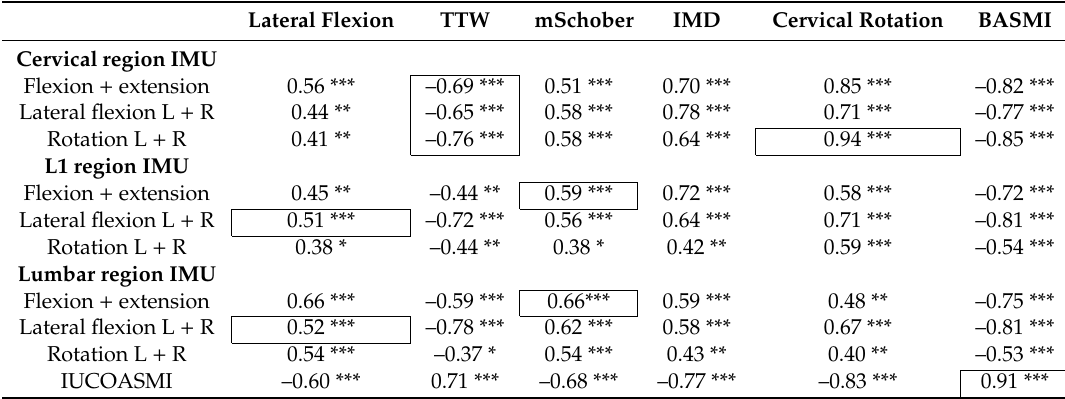
Table 4. Correlation between measures obtained by IMUs and conventional